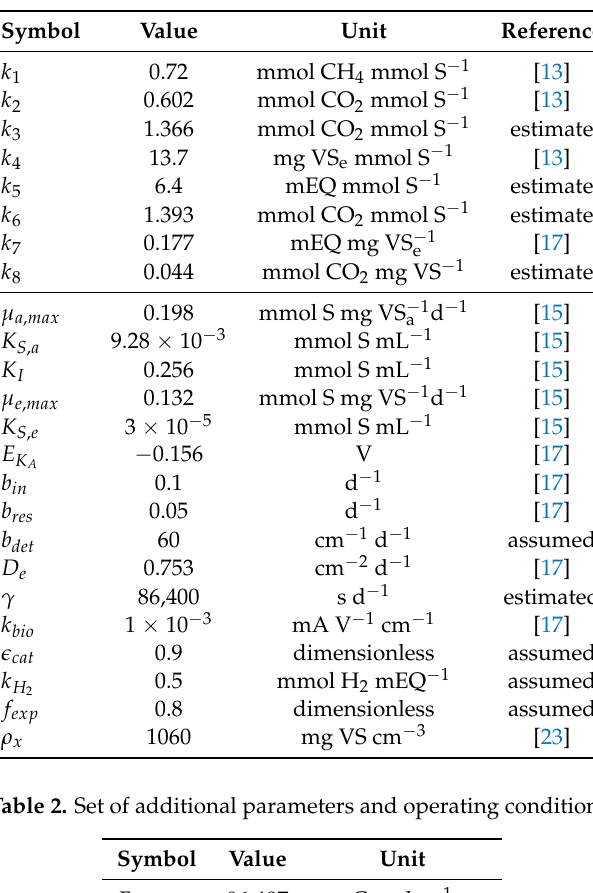
Table 1. Set of nominal parameters.